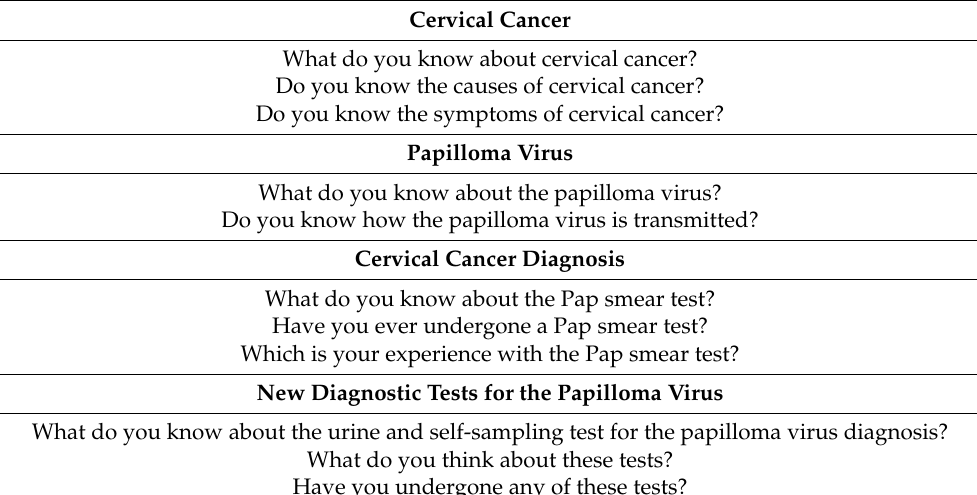
Table 1. Focus group interview